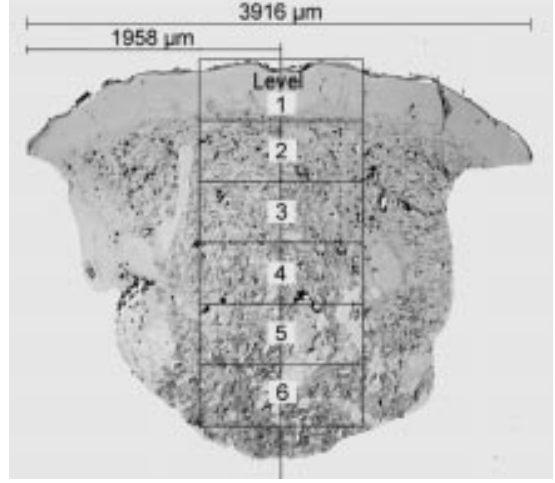
Fig. 1. Sampling strategy. Determination of the mean immunoposi- tive area fraction (MeanIAF) by serial field selection along a central line from stratum corneum to subcutis. Two fields on both sides of the central line with a width of 632.6 (cid:22) m and a depth of 464.2 (cid:22) m were measured in each level of